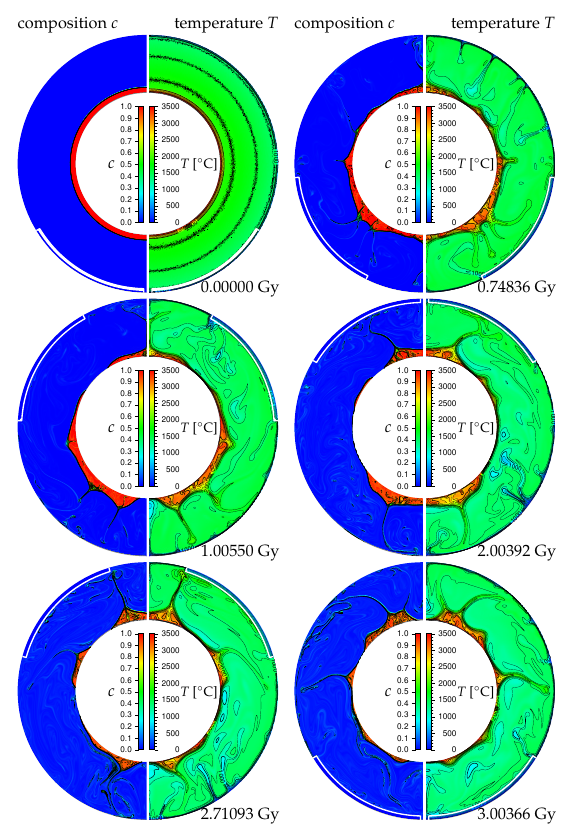
Figure 13. Same as Figure 3, but for Case 7.